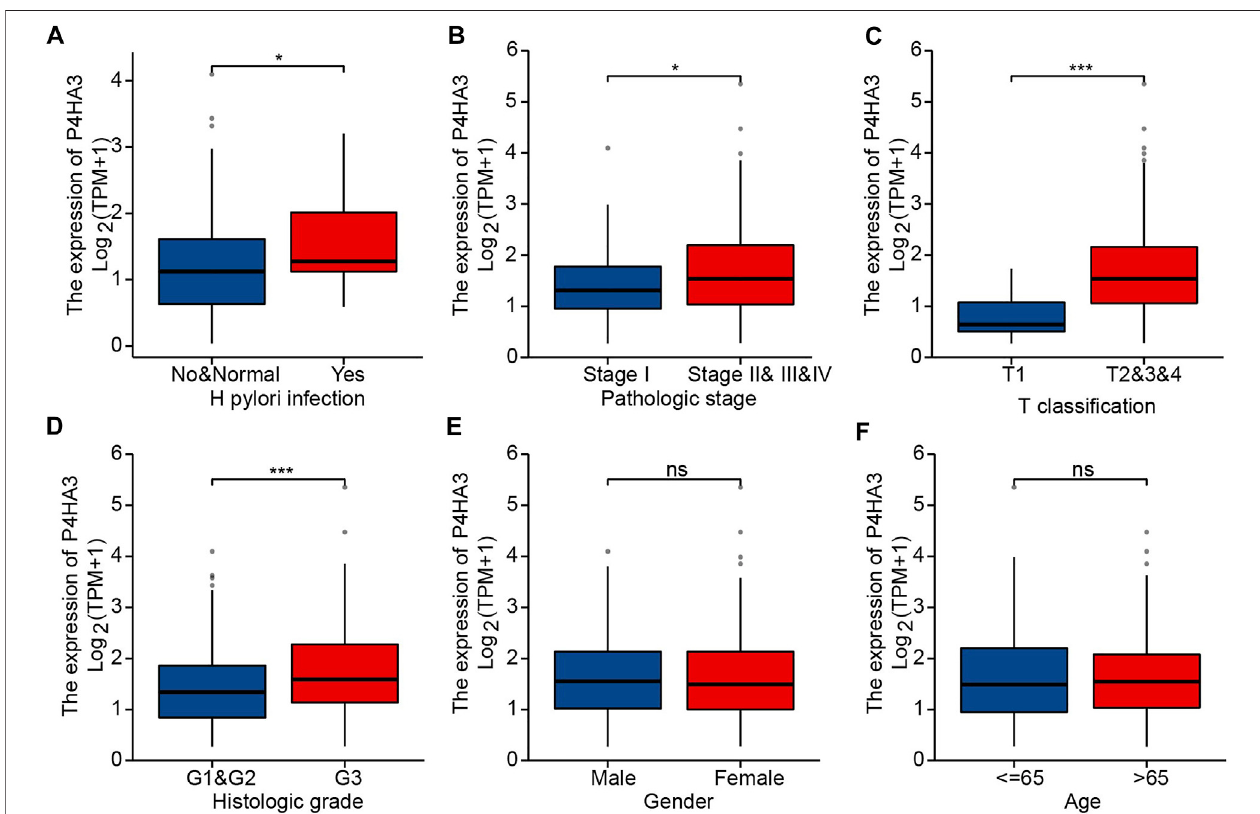
FIGURE 3 | P4HA3 expression is associated with clinicopathological characteristics. (A) Post-mortal P4HA3 expression levels were higher; (B) Late stage P4HA3 expression levelswerehigher; (C) P4HA3expression levelswerehigherinpatientswithhigherTclassi fi cations; (D) P4HA3 expressionlevelswerehigherinpatients with lowerhistologicalgrades; (E) NogenderdifferenceswerefoundforP4HA3expressionlevels; (F) Noage-relatedchangeswerefoundinP4HA3expressionlevels.ns, p ≥ 0.05; *, p < 0.05; ***, p < 0.001.